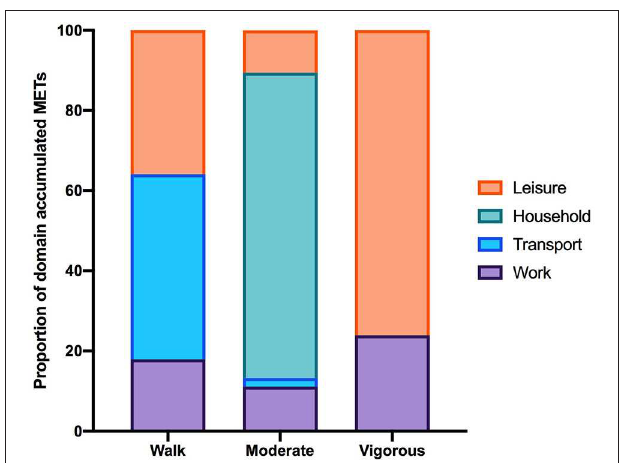
FIGURE 1 | The proportion of the total MET-min/wk in each activity category accumulated per IPAQ domain. Data excludes participants who did not report accumulating activity in any of the activity categories therefore the number of participants in each activity category is 190, 203, and 69. Note that in the household domain activities are all assigned MET values within the moderate-intensity